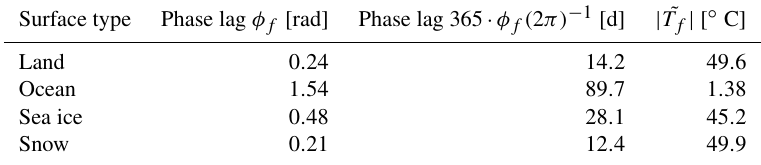
Table 7. Theoretical average phase lags (Eq. 9) and amplitudes (Eq. 8) in TransEBM for the different surface types and annual forcing.